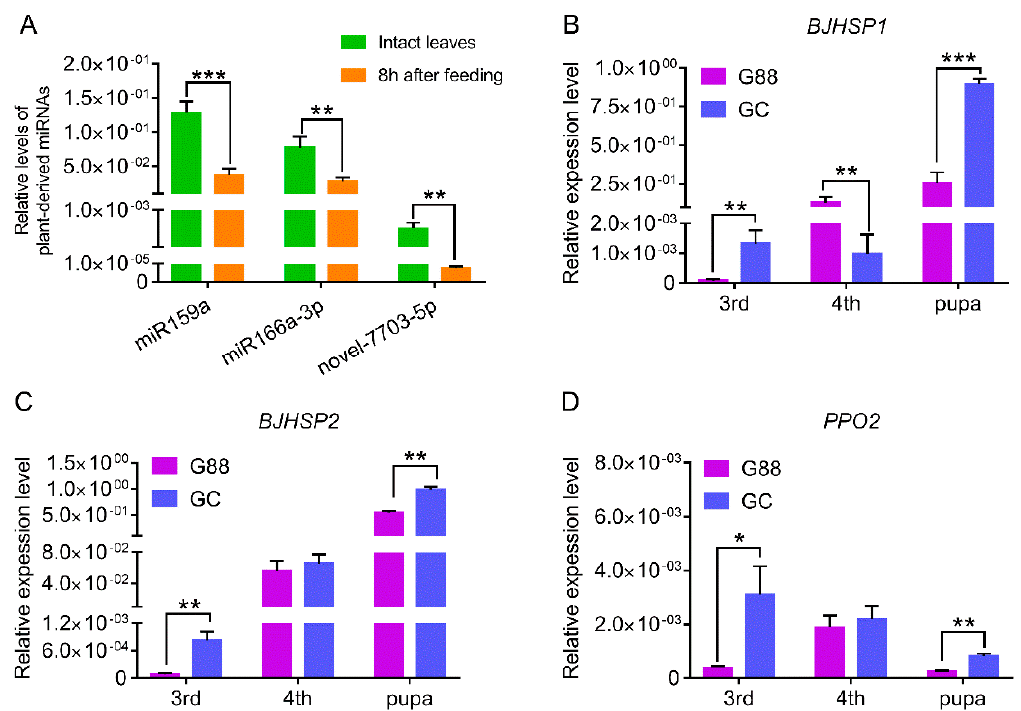
Figure 7. Expression of the plant-derived miRNAs and corresponding target genes in P. xylostella after host transfer. ( A ) Expression of miR159a, miR166a-3p and novel-7703-5p in intact leaves of A. thaliana and leaves fed by the 3 rd instar larvae of G88 for 8 h. Data were presented as mean ± SD (Student’s t test, ** p < 0.01 *** p < 0.001,) ( B – D ). Expression of BJHSP1 ( B ), BJHSP2 ( C ) and PPO2 ( D ) in the 3 rd